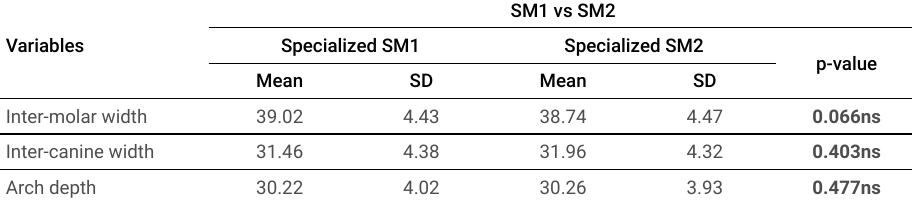
Table 2. Mean and standard deviation (SD) values of SM1 vs